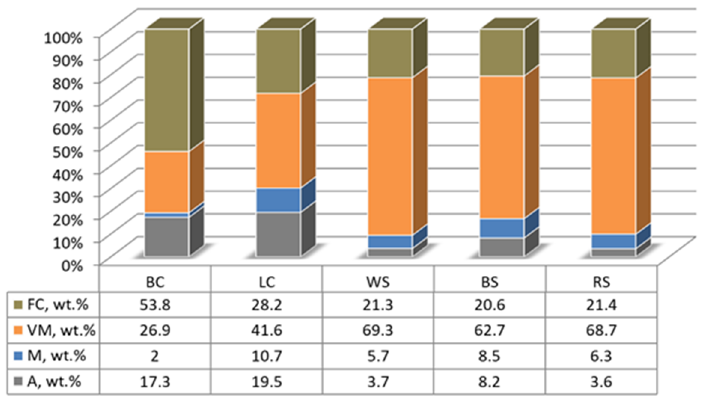
Figure 3. The proximate analysis (A—ash, M—moisture, VM—volatile matter, FC—fixed carbon) of fuel samples on air dried basis; BC—bituminous coal, LC—lignite, WS—wheat straw, BS—barley straw, RS—rye straw.